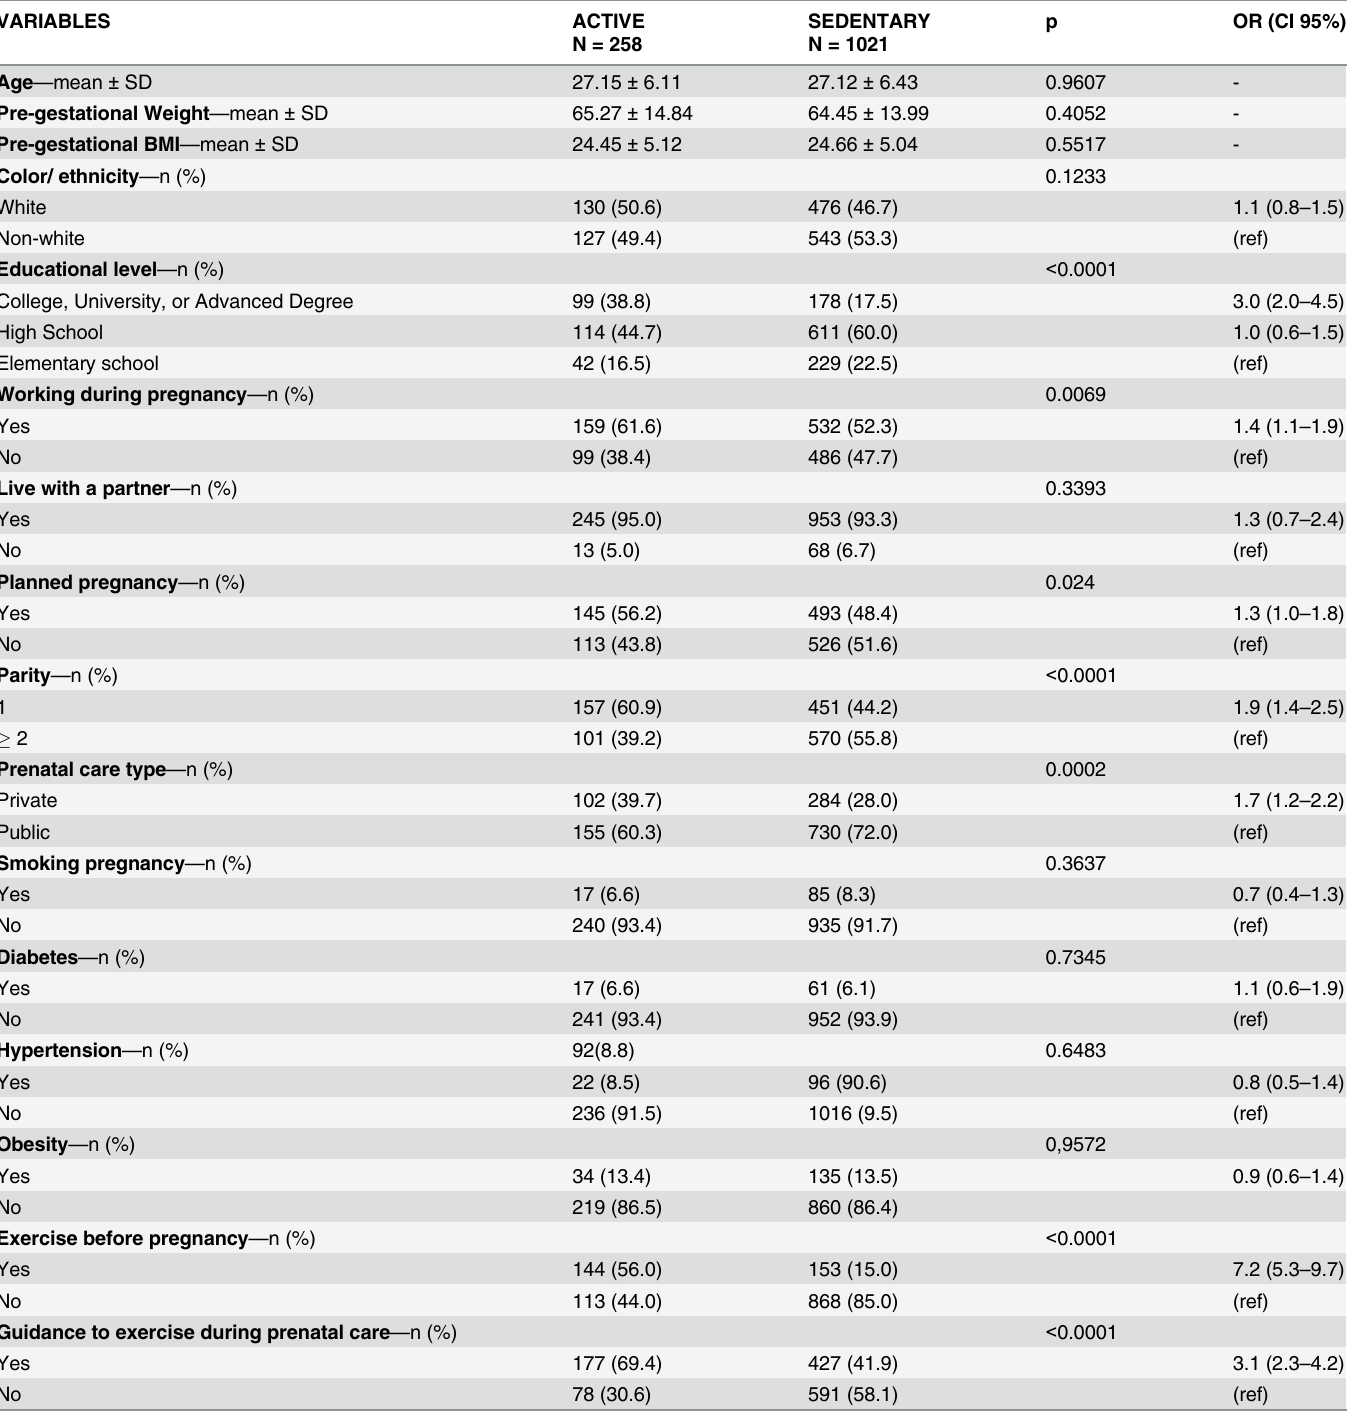
Table 3. Women characteristics according to physical activity during pregnancy (active or